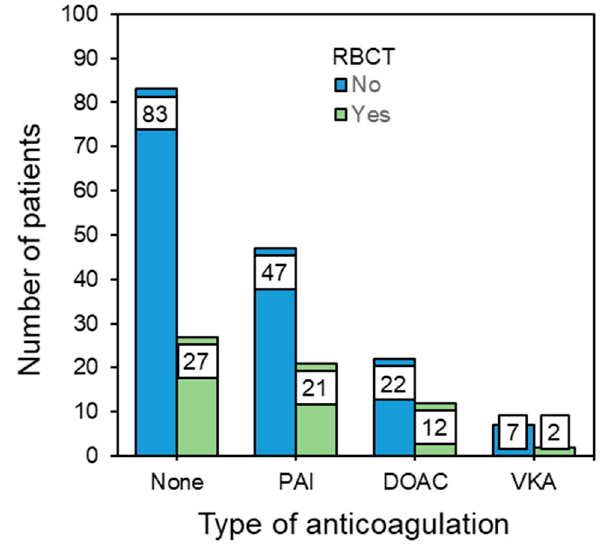
Figure 3. Red blood cell transfusion (RCBT) depending on anticoagulative medication. PAI: Platelet aggregation inhibitors including acetylsalicylic acid; DOAC: Direct oral anticoagulants; VKA: Vita- min-K-antagonist Warfarin.